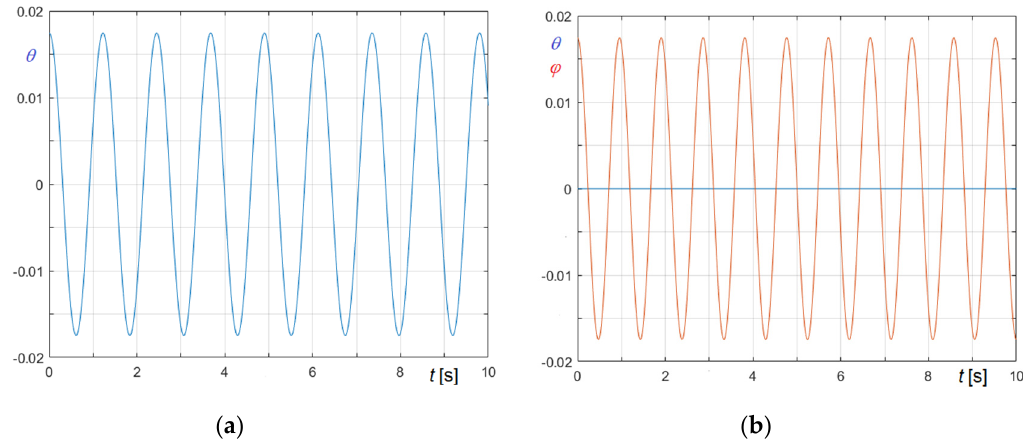
Figure 5. Small free oscillations of the St. Mary’s tenor bell: ( a ) Oscillation of bell in case of bell excitation; ( b ) Oscillation of bell and clapper in case of clapper excitation.